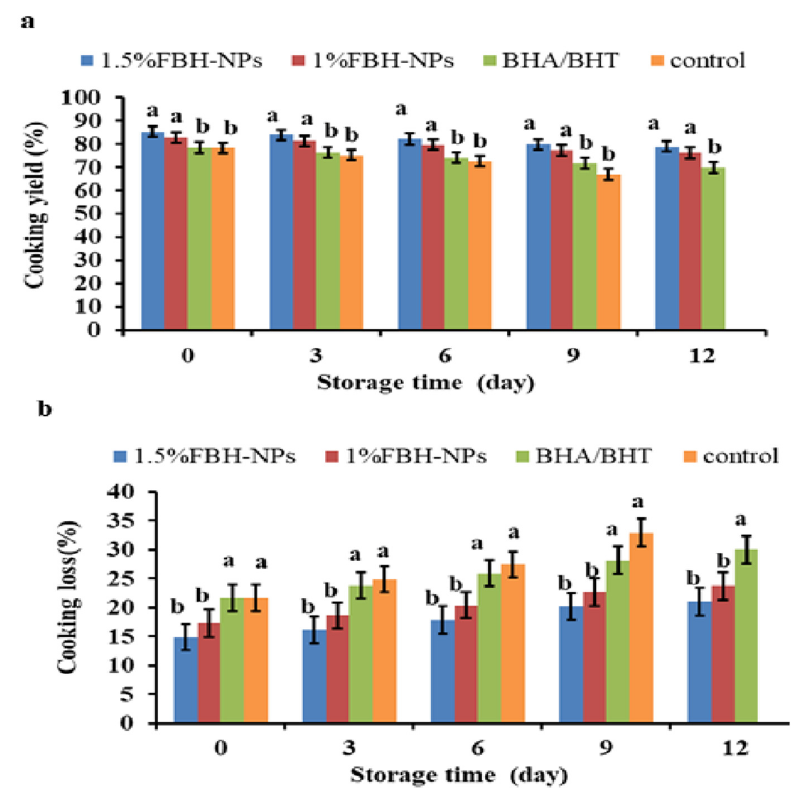
Figure 2. Changes in cooking yield ( a ) and cooking loss ( b ) percentages of burgers incorporated with FBH ‐ NPs and BHA/BHT during storage at 4 ± 1 °C. Error bars represent standard deviation, ( n = 3). Different superscripts lowercase letters indicate significant differences at p < 0.05 between treatments at each storage time.